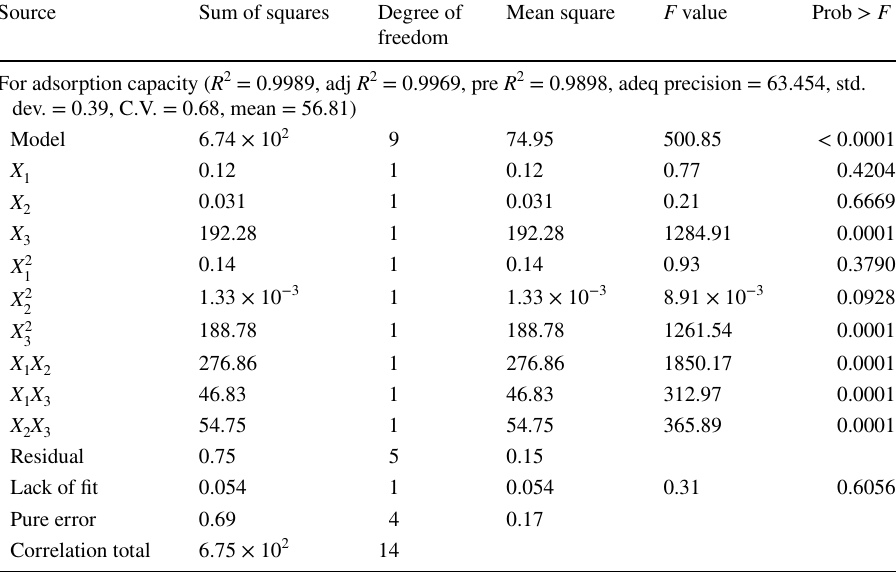
*Indicates significant